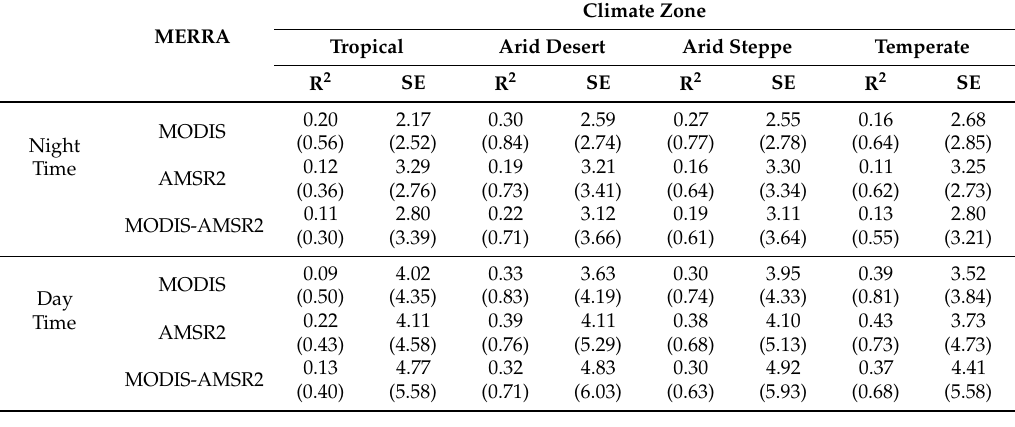
Table 2. Summarized statistics for the MERRA comparison against the individual MODIS and AMSR2 LST products and the combined product in which cloud gaps in MODIS were filled with scaled AMSR2 observations. Note that the statistics for the anomalies were presented first and those for the raw timeseries were presented within brackets.